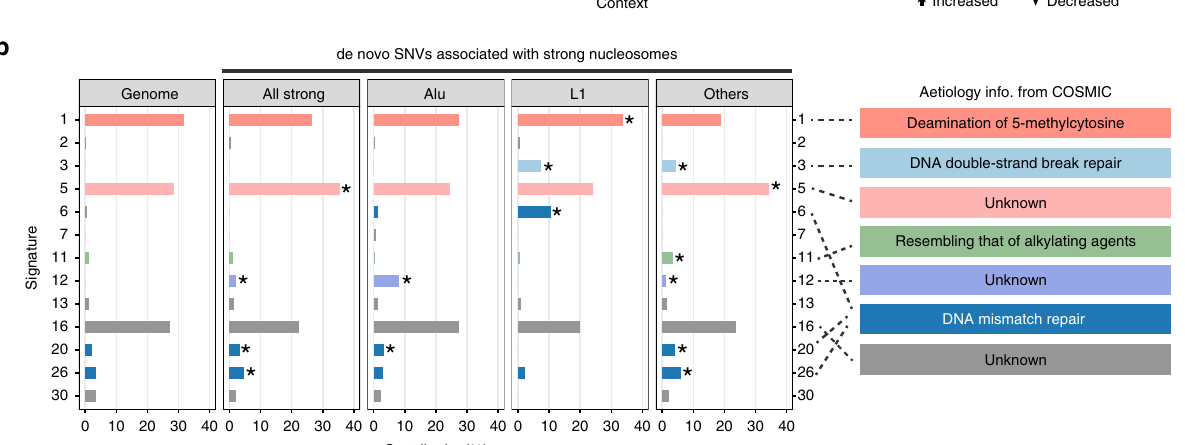
Fig. 3 De novo SNVs in strong nucleosomes display distinct mutation type frequencies and COSMIC mutational signatures. a Frequencies of 96 mutation types among de novo SNVs; six nucleotide substitutions in the context of the bases immediately 5 ′ and 3 ′ of the mutated site. SNVs are grouped into those overlapping strong nucleosomes and those elsewhere, and among the former into those overlapping with different classes of repeat elements. ↑ and ↓ indicate mutation types showing statistically signi fi cant differences relative to the genomic background SNV set (adjusted p < 0.05, two-sided Fisher ’ s exact test). b Percentage contribution of COSMIC mutational signatures among different groups of SNVs; only signatures with nonzero values are shown. Asterisks indicate mutational signatures displaying >1% increase relative to the genomic background SNV set. Brief summaries of the aetiologies of affected signatures are shown on the right (descriptions taken from the COSMIC website). Source data are provided as a Source Data fi